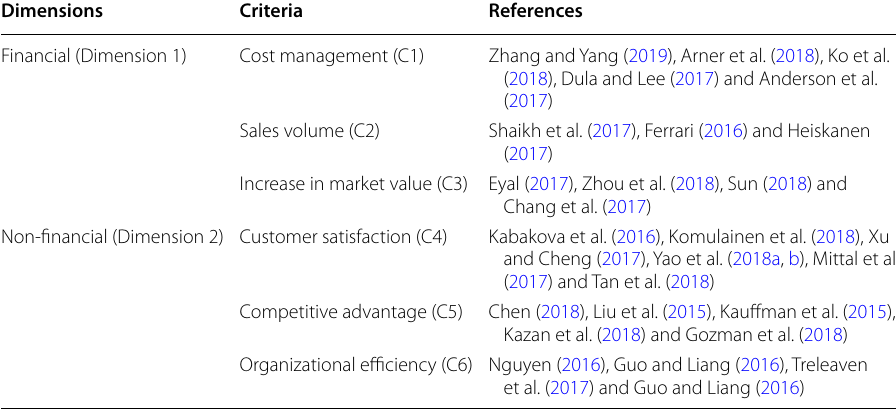
Table 1 Fintech-based determinants of the European banking sector. Source : Created by the